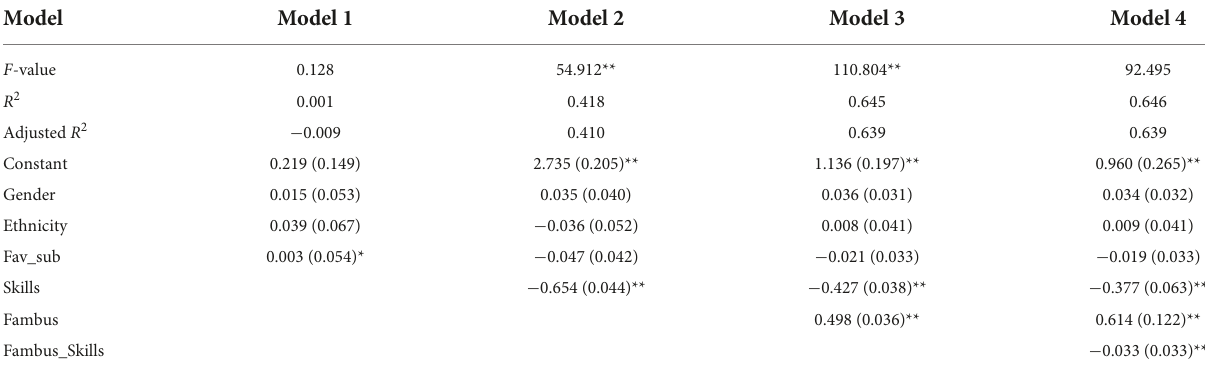
TABLE 5 Hierarchical regression results: The role of entrepreneurial skills and family business on self-employment